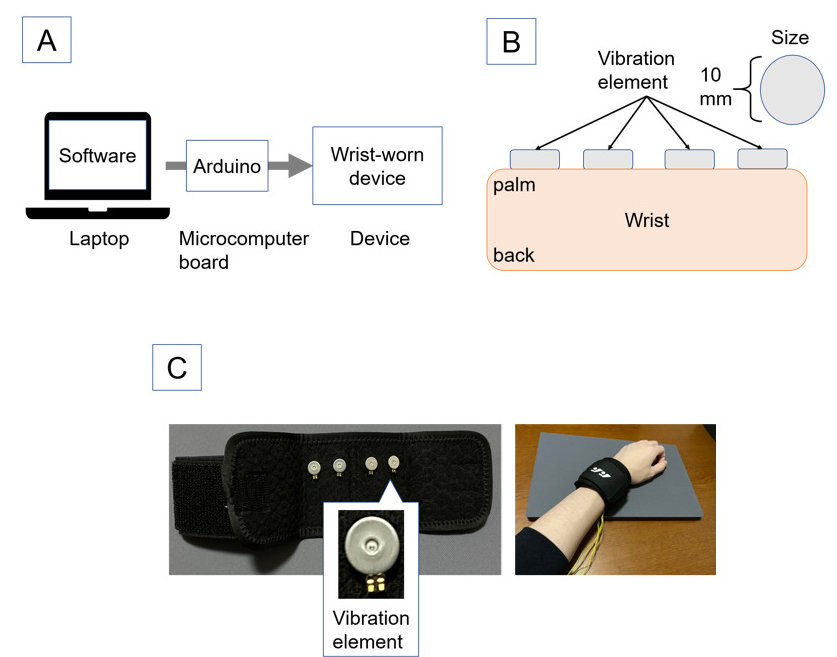
Figure 3. System configuration and implementation device. ( A ) is the system configuration. ( B ) is a diagram of the implementation device. ( C ) is the implemented wrist-worn device. Reprinted/adapted with permission from Ref. [11] 2021,